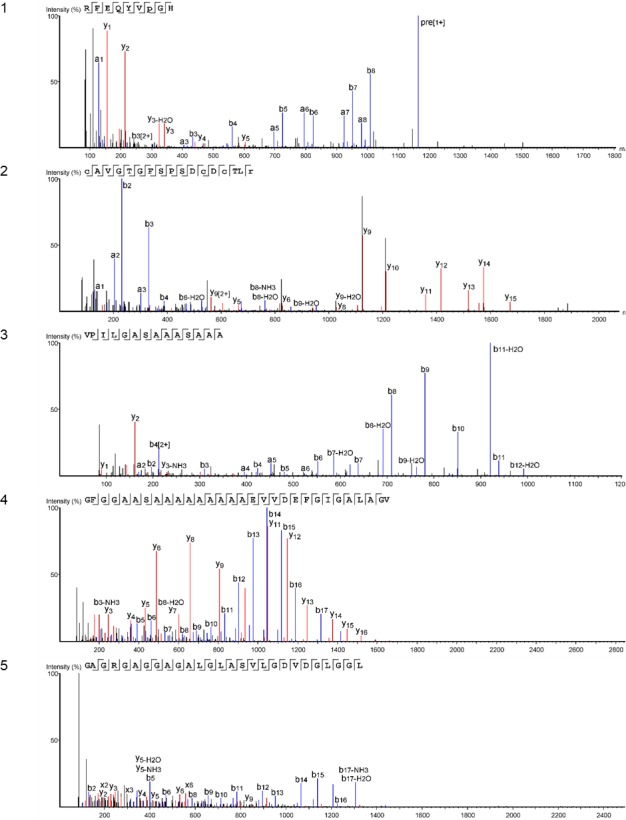
Product ion spectra [1 - 5] supporting the coverage of protein Hic74 identified in the double-button HavC.